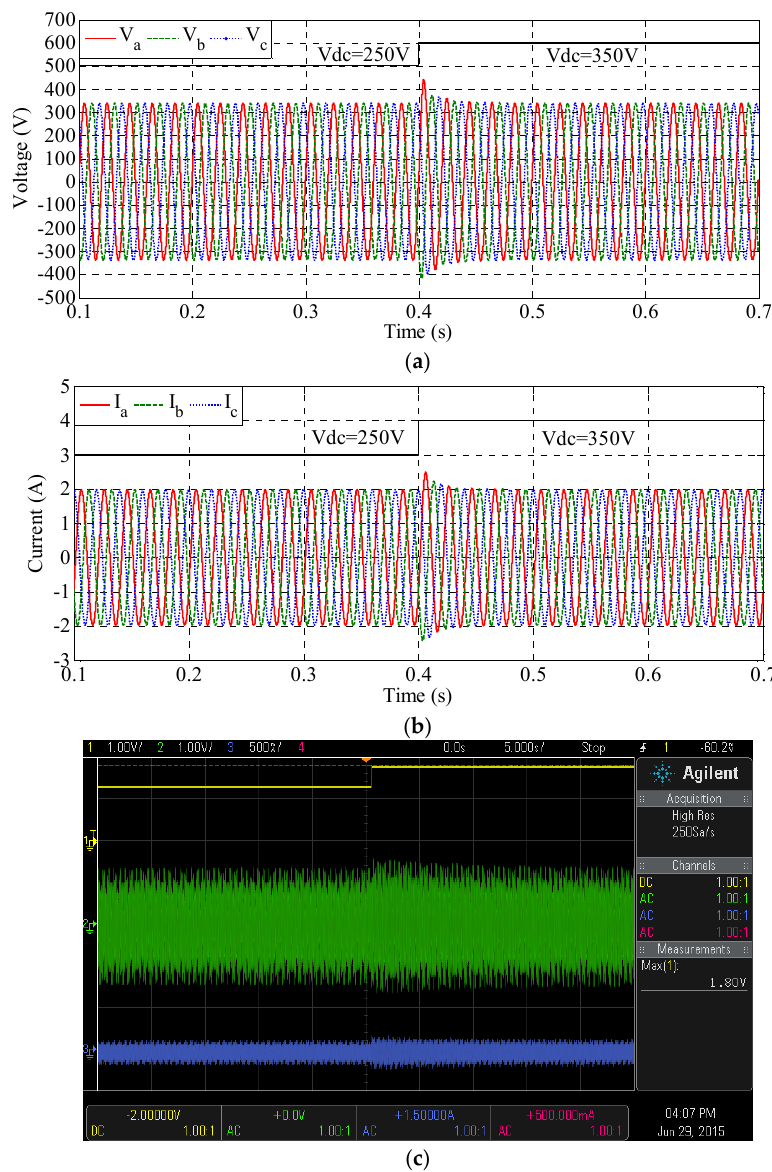
Figure 27. Output waveforms with V dc increasing from 250 V to 350 V with RL load. ( a ) Simulation voltage waveforms; ( b ) simulation current waveforms; and ( c ) experimental voltage and current waveforms (Ch. 1, Ch. 2, and Ch. 3 for V dc , V a , and I a ,